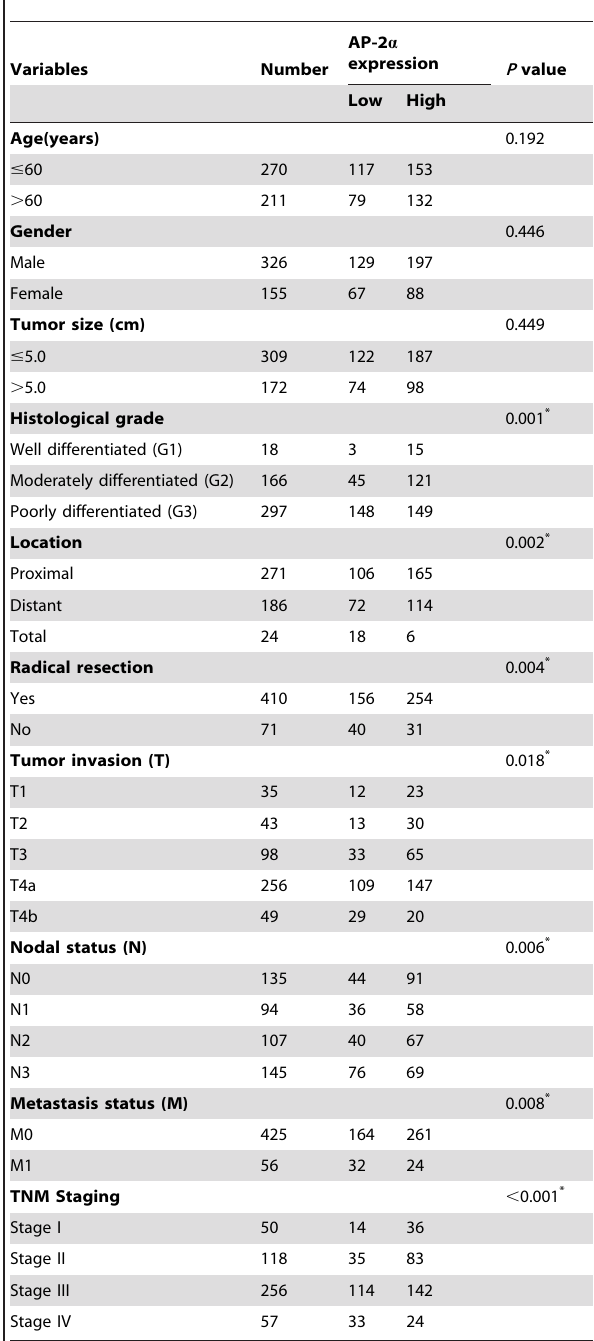
Table 1. Relationship between AP-2 a expression and clinicopathologic features of patients with gastric